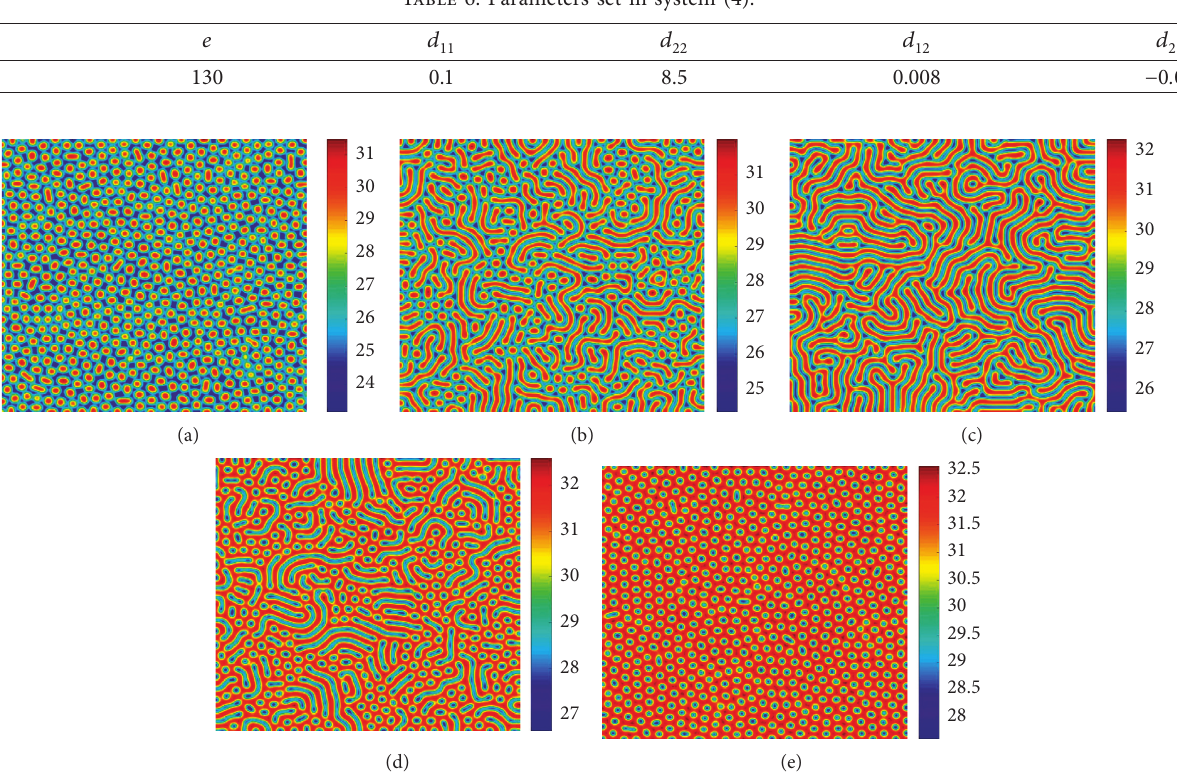
Figure 6: Spatial patterns of the predator induced by conversion rate of prey into predator biomass; other parameters are set as in Table 5. (a) c � 0 . 007041633659, (b) c � 0 . 008509501103, (c) c � 0 . 009332994621, (d) c � 0 . 01032204568, and (e) c � 0 .